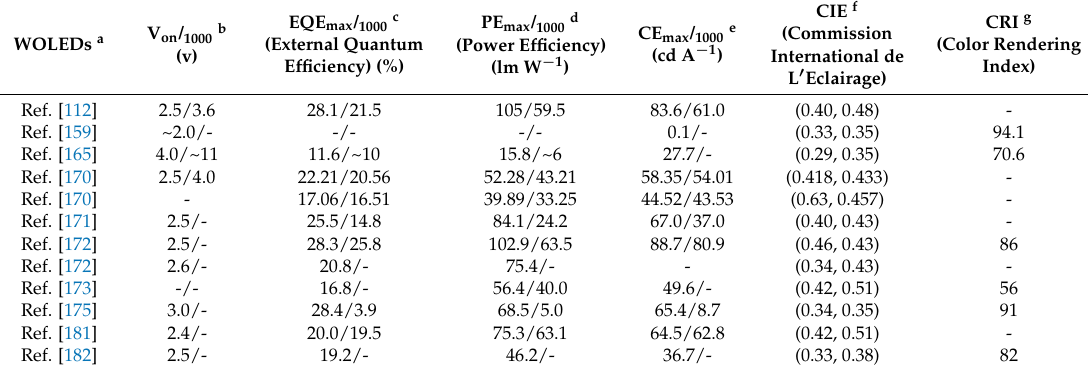
Table 1. Summarized performances for representative exciplex-based white organic light-emitting diodes (WOLEDs).